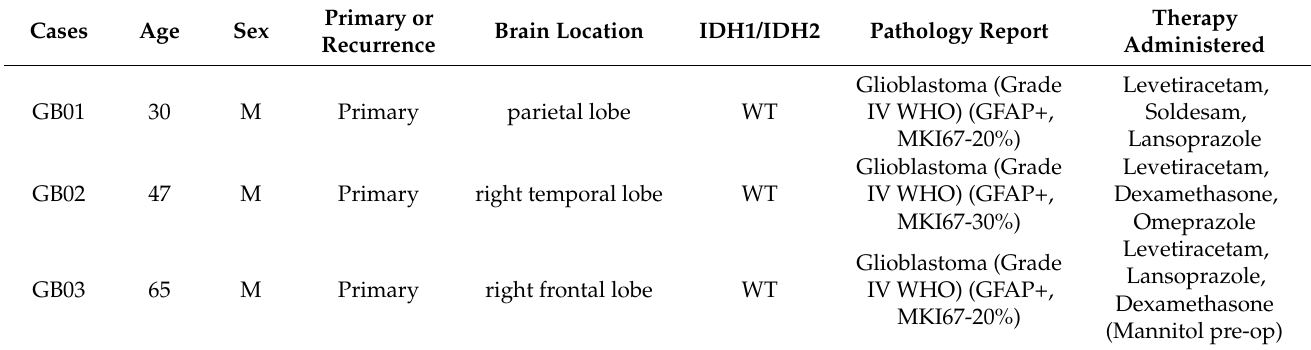
Table 1. Patient clinical, demographic, pathological, and therapeutical